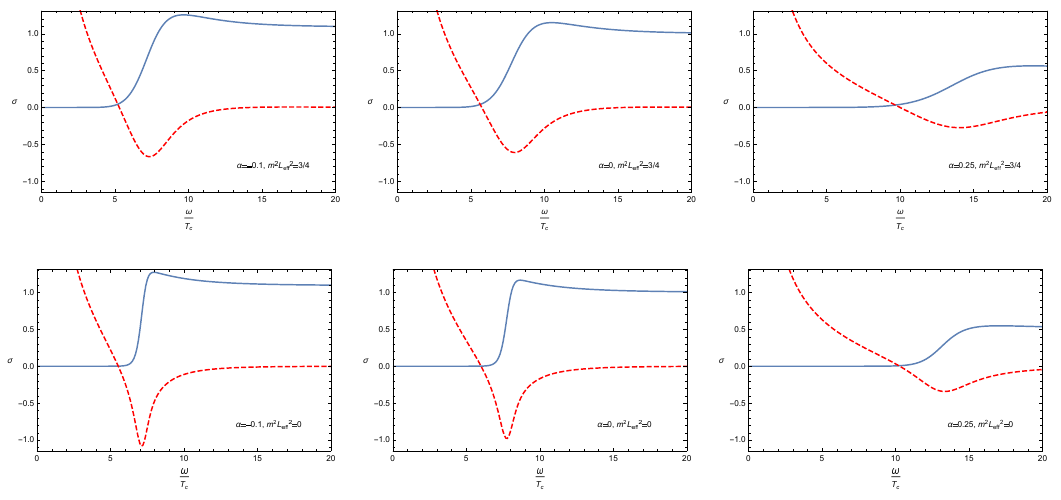
Figure 8 . Conductivity of the ( 2 + 1 )-dimensional p-wave superconductors for different values of the Gauss-Bonnet parameter with the fixed vector field masses m 2 L 2 panel, the blue (solid) line and red (dashed) line represent the real part and imaginary part of the conductivity σ ( ω )